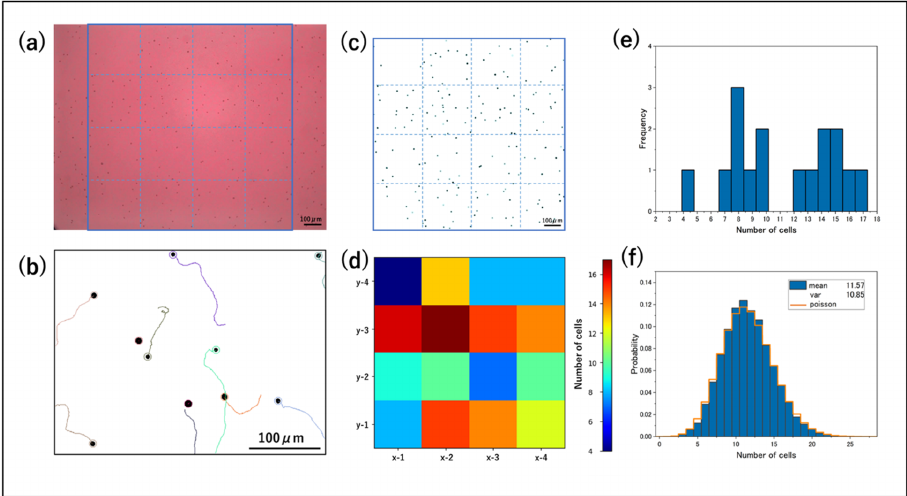
Figure 4. Analysis using 4 × 4 partitioning and particle track. ( a ) Acquired videos and the observation area used for analysis (in blue box). The background appears red because the red LED (660 ± 10 nm) was used for observation. The stage of the microscope was adjusted so that the center of the ring was at the center of the movie. The square area in the center was used for analysis. ( b ) Particle tracking for 2 s at 30 fps. The trajectory of the tracked particles is shown. The trajectory is not output for a stationary object. ( c ) Partition in the binarized image. ( d ) Heatmap of counts in ( c ). ( e ) Histogram at 1 frame in ( c ). ( f ) Histogram over 900 frames for 15 min. A video adjusted to be one frame per second (by thinning out 29 frames) was analyzed.